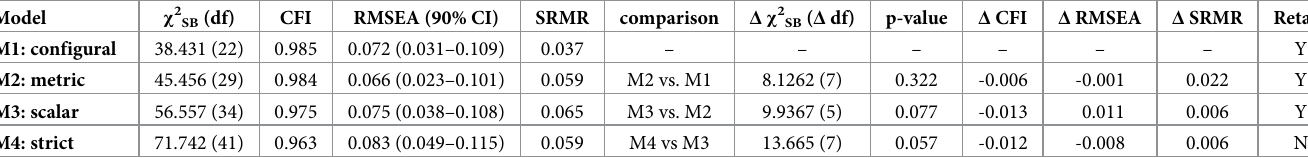
Table 6. Tests of measurement invariance between pen-and-paper (N = 224) and computer-based (N = 320). Model χ 2 SB (df)